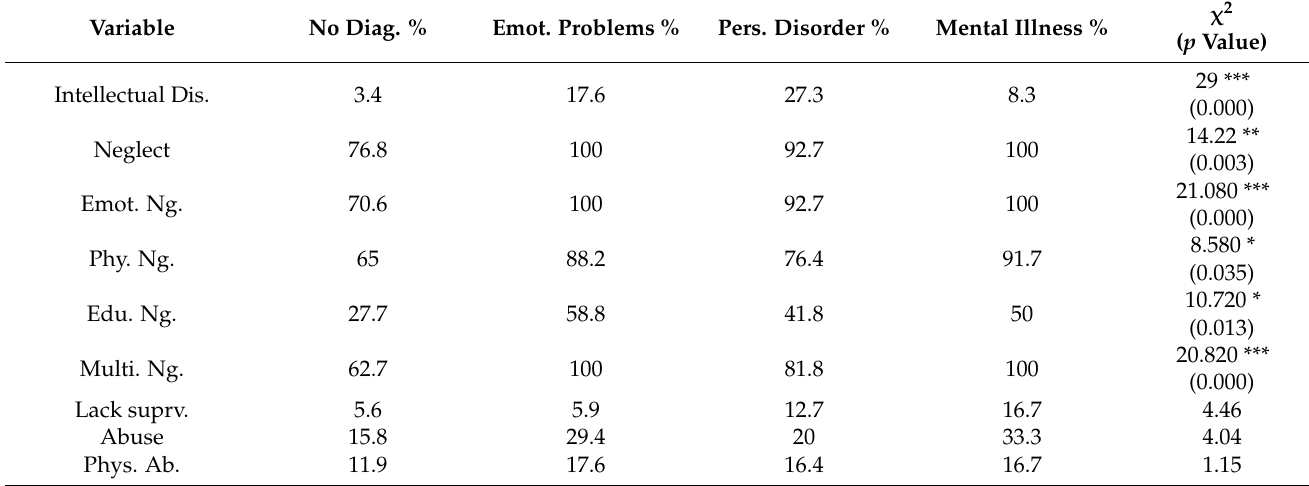
Table 4. Associations between Fathers’ Mental Health Diagnoses and Child